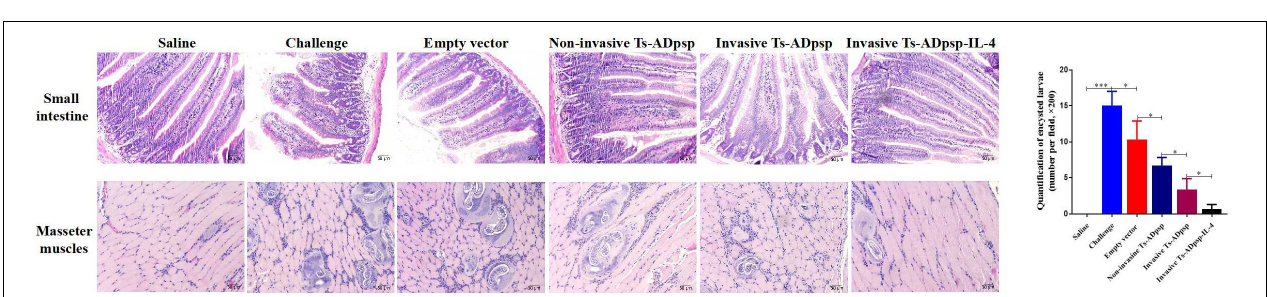
FIGURE 7 | Worm burden in mice following T. spiralis infection with or without vaccination. Adult worm (A) and larvae per gram of muscle (LPG) burden (B) of vaccinated mice after infection with 350 T. spiralis muscle larvae. Data are presented as mean ± SEM ( n = 8 mice per group). * P < 0.05, ** P < 0.01, and *** P < 0.001.